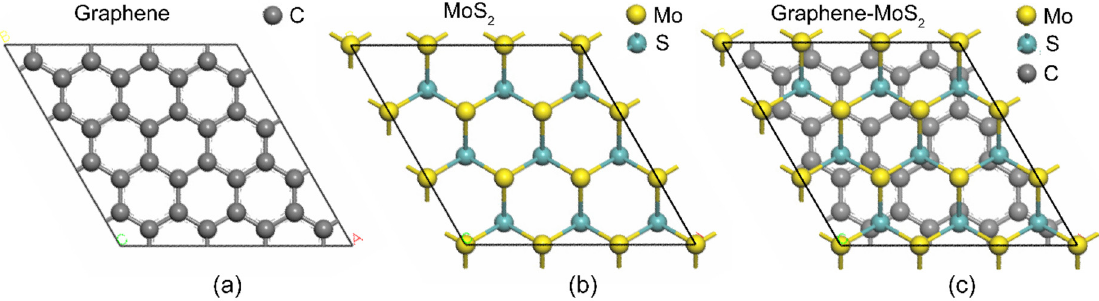
Figure 1. Atomic structure of ( a ) graphene, ( b ) MoS 2 , and ( c ) graphene-MoS 2 .